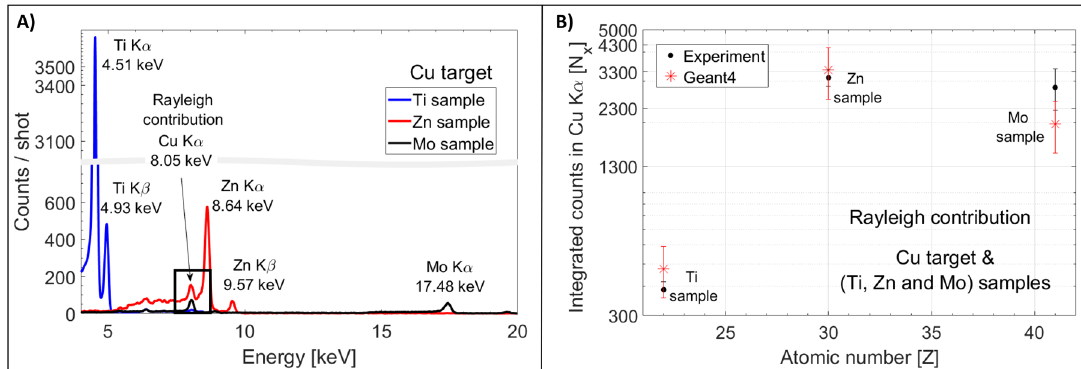
Figure 2. X-ray spectra and Rayleigh contribution. ( A ). X-ray spectra as obtained by the interaction of laser- based sources produced by a Cu target and a Ti, Zn and Mo sample. The Rayleigh contribution from the Cu X-rays is visible around 8 keV (see black box). ( B ) Integrated number of counts in the Cu K α Rayleigh peak in Geant4 simulations when 8.05 keV photons were sent in the sample, scaled to 4.3 × 10 10 ± 1.1 × 10 10 incident